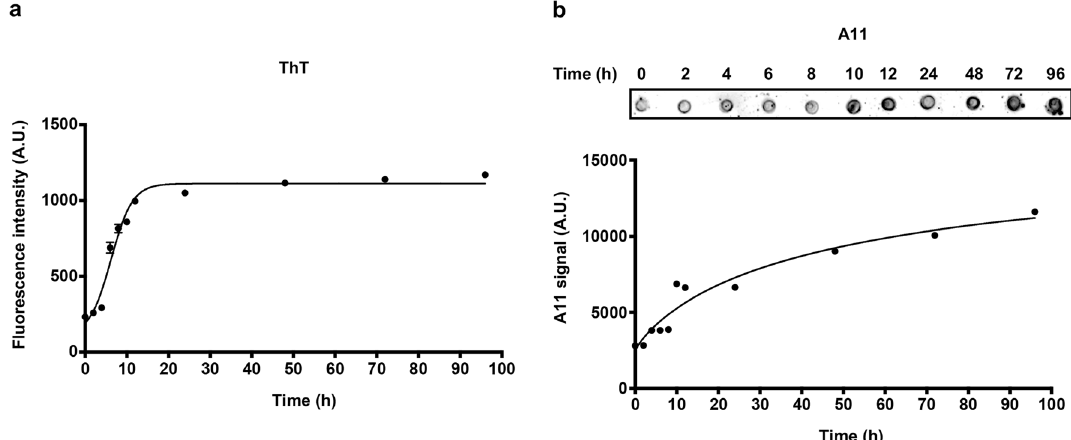
Figure 2. ThT fluorescence assay and dot blotting analysis of Aβ pE3-42 aggregation. Aβ pE3-42 (25 μM) samples ◦ were incubated for the time points (0, 2, 4, 6, 8, 10, 12, 24, 48, 72, 96 h) at 37 C. ( a ) Each of incubated Aβ pE3-42 sample was interacted with ThT and the fluorescence intensity was measured by the fluorescence microplate reader. ( b ) Utilizing anti-oligomer polyclonal A11, dot blotting and densitometric analysis were performed to detect oligomeric forms of incubated Aβ pE3-42 samples. The original dot blots and uncropped full-membrane results with A11 are presented in Supplementary Figure S4. The error bars represent S.E.M. Aβ pE3-42 ,